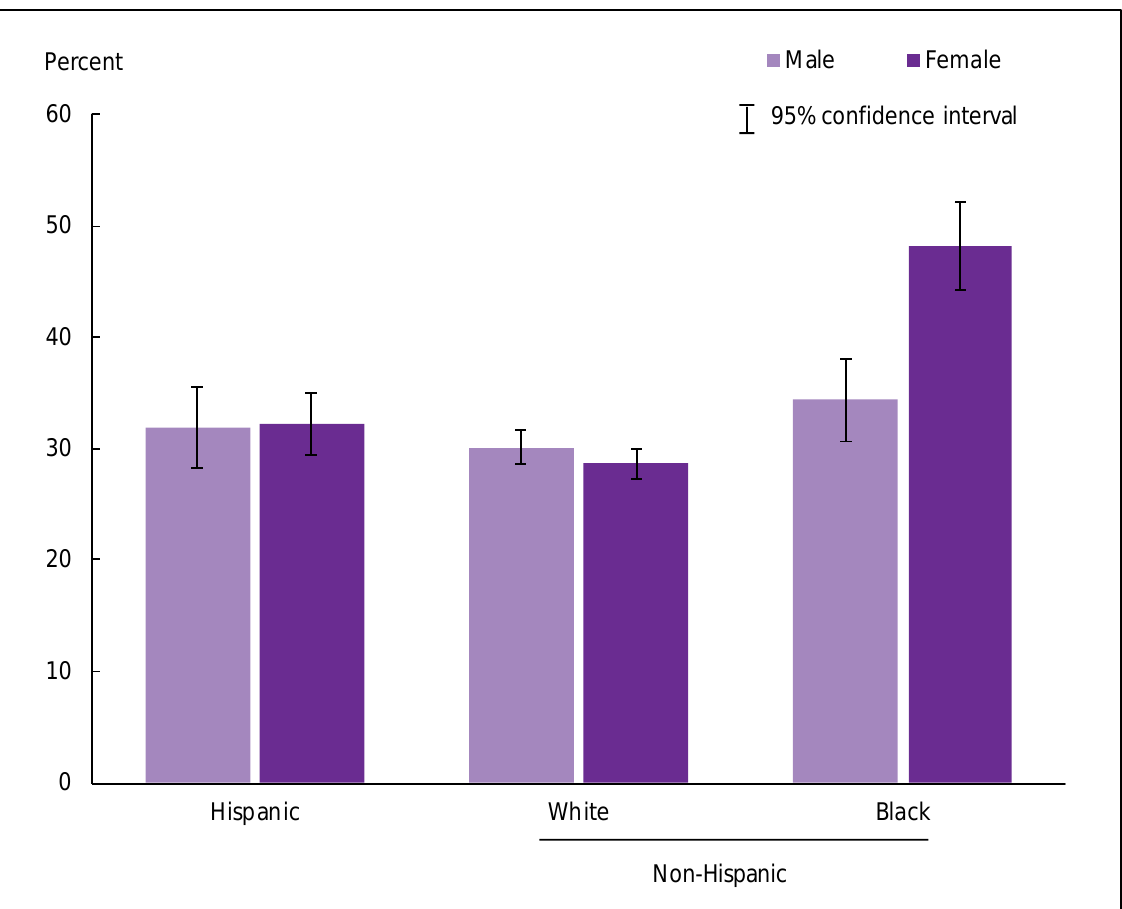
Figure 6.3. Age-adjusted prevalence of obesity among adults aged 20 and over, by sex and race and ethnicity: United States,